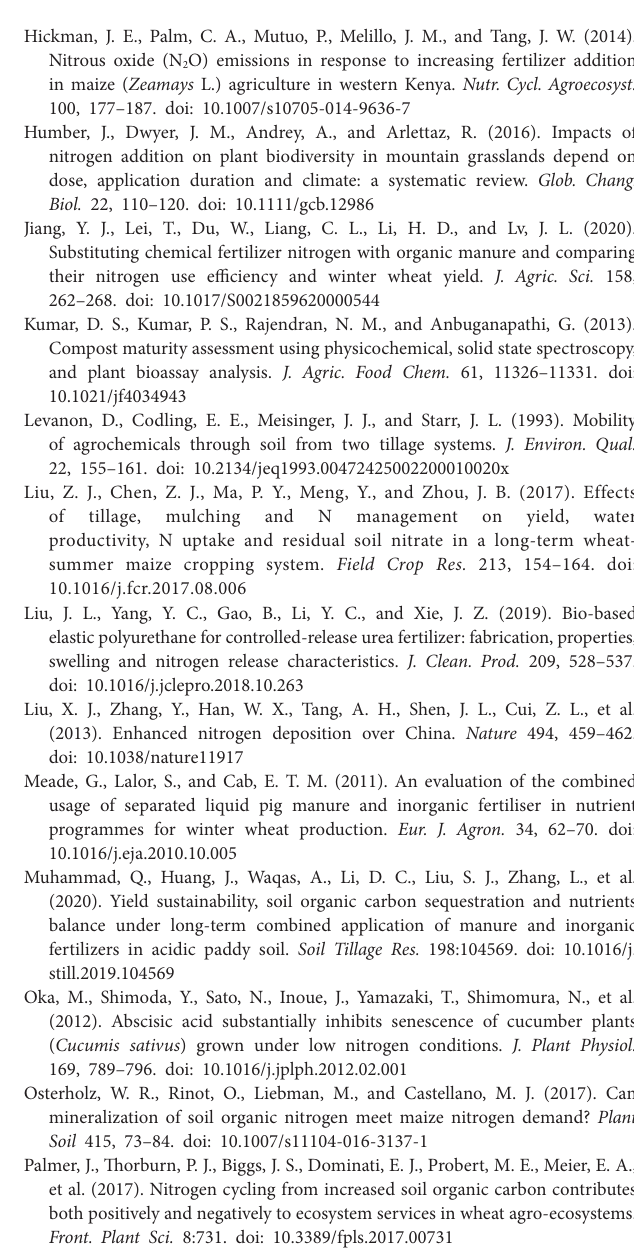
Supplementary Figure S1 | SEM images of the surface morphology of CU films. Panels A1, A2, and A3 show the CU surfaces before fertilization at 5 μ m, 10 μ m, and 50 μ m, respectively. Panels B1, B2 and B3 show the CU surfaces after burial in soil at 5 μ m, 10 μ m, and 50 μ m, respectively. Supplementary Figure S2 | FTIR spectra of organic fertilizer. Supplementary Figure S3 | Bulk density of the 0–20-cm topsoil in